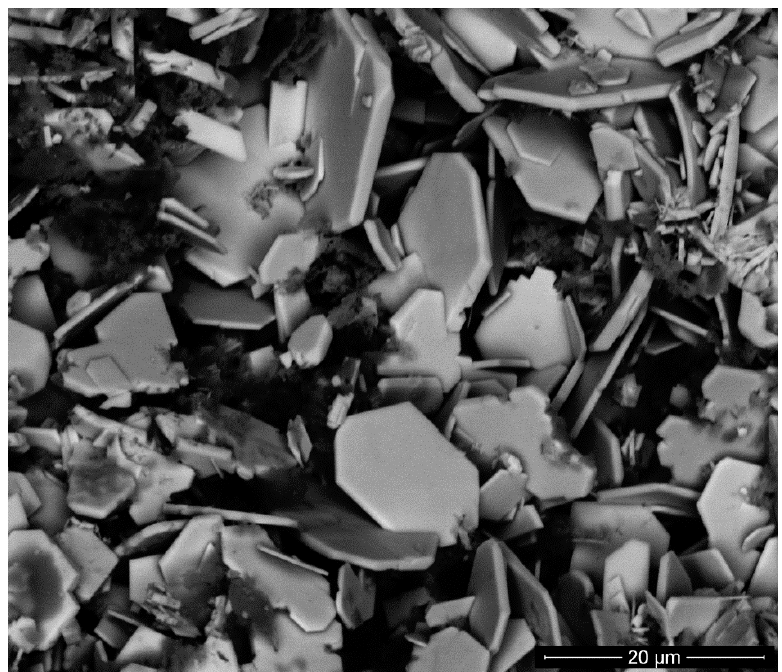
Figure 3. Backscattered electron (BSE) image of the baryte aggregate.